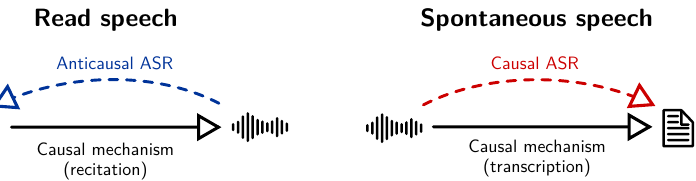
Figure 3. Conceptual illustration of the different generative processes underlying read and spon- taneous speech. Solid arrows indicate the direction of the process, dashed arrows the direction of the